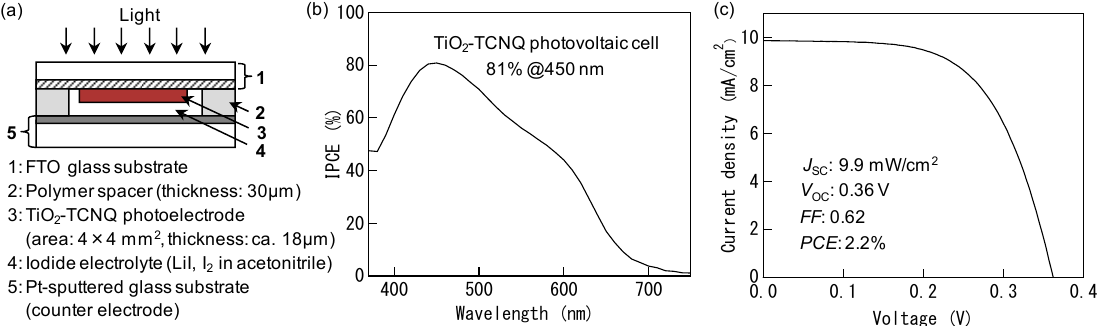
Figure 5. ( a ) Structure of TiO 2 -TCNQ photovoltaic cells fabricated in our study and ( b ) incident photon-to-current conversion efficiency (IPCE) excitation spectrum and ( c ) J-V curve under simulated solar irradiation (AM1.5G, 100 mW/cm 2 ) of TiO 2 -TCNQ photovoltaic cell with iodide electrolyte (LiI: ca. 2 M, I 2 : 0.025 M, solvent: acetonitrile).